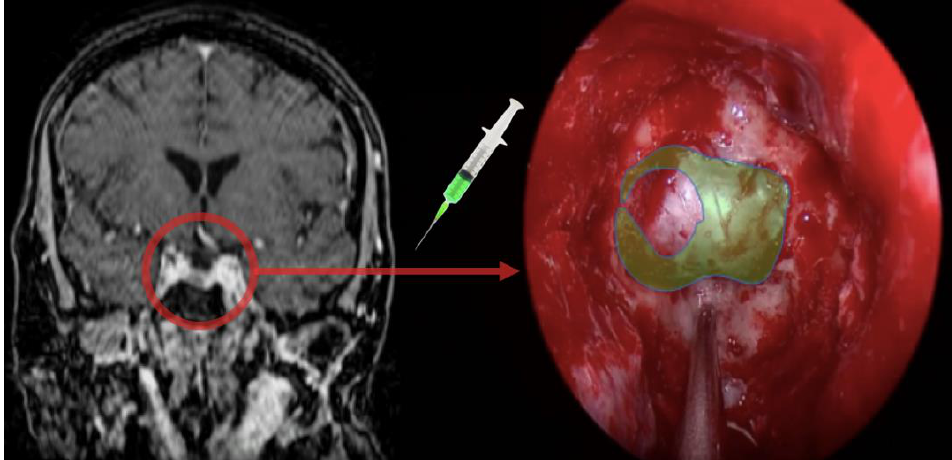
Figure 2. Rationale of the use of fluorescein as a gadolinium analog in real time visualization.